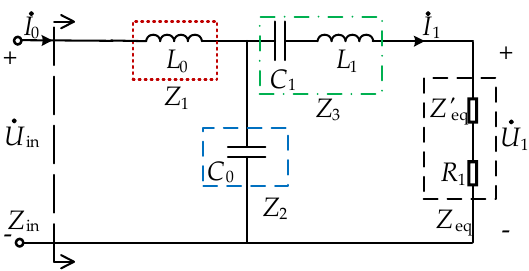
Figure 2. LCC-S type resonant equivalent circuit.